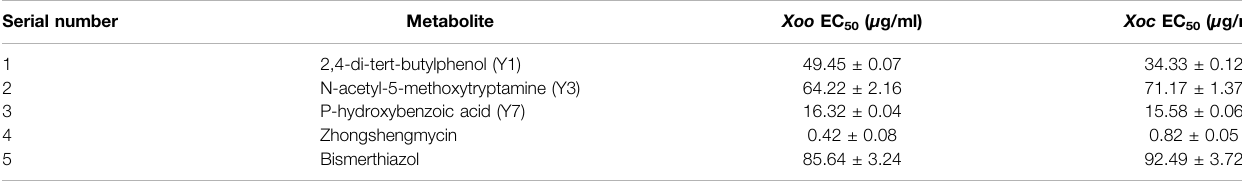
TABLE 2 | EC 50 values of the 2,4-di-tert-butylphenol, N-acetyl-5-methoxytryptamine, P-hydroxybenzoic acid, zhongshengmycin, and bismerthiazol against Xoo and Xoc . Serial number